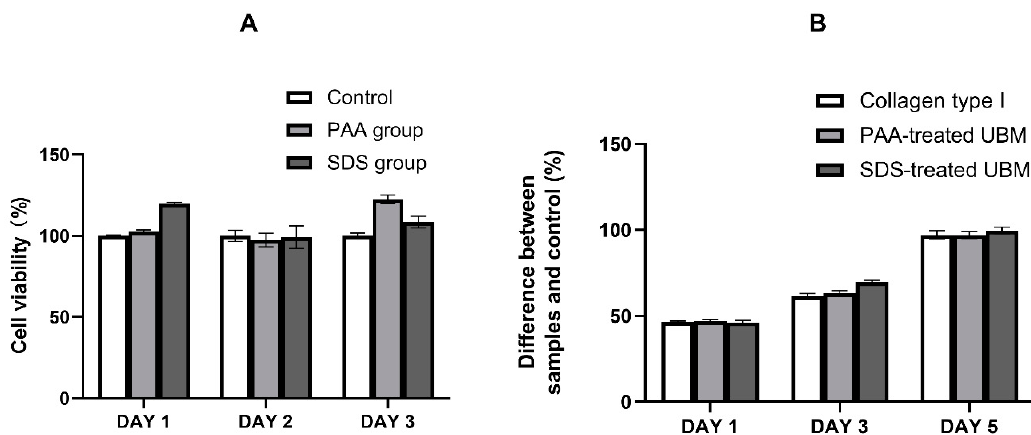
Figure 6. UBM hydrogel cytocompatibility. ( A ) In vitro cytotoxicity of the ECM powder studied by MTT assay. ( B ) Cell proliferation on hydrogel surface evaluated by Alamar blue assay.